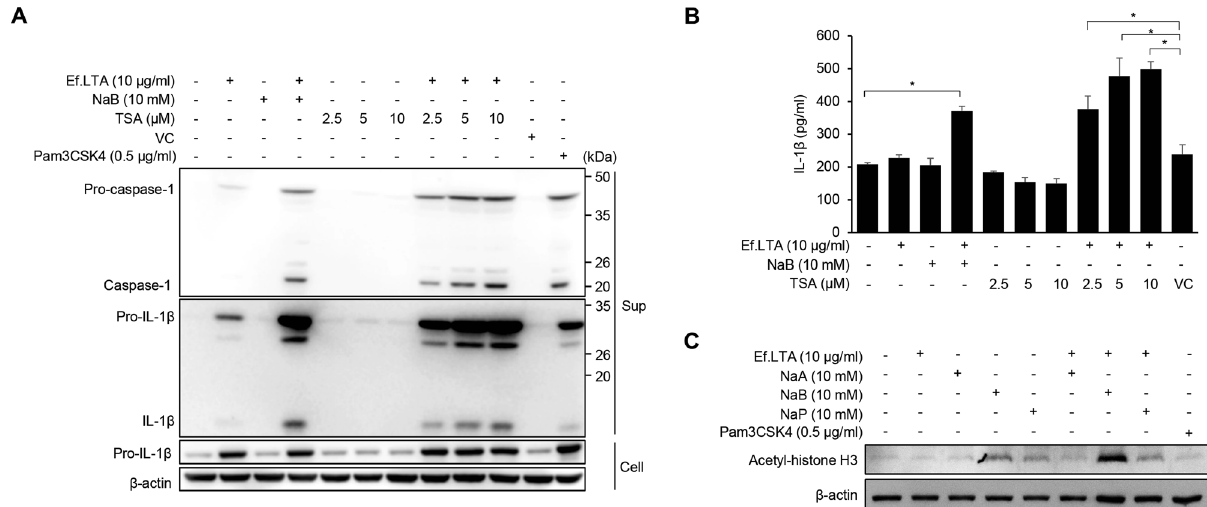
Fig. 7 HDAC inhibition is necessary for in fl ammasome activation by Ef.LTA/NaB. A PMA-differentiated THP-1 cells were stimulated with Ef.LTA (10 μ g/ml) in the presence of NaB (10 mM) or indicated concentrations of trichostatin A (TSA) for 6 h. Then, the culture supernatants were collected and the levels of pro- or active caspase-1, IL-1 β were determined by immunoblotting. B The concentrations of IL-1 β secreted into the culture supernatants was measured using ELISA. The results shown are representative of triplicate experiments. Pam3CSK4 was used as a positive control. VC denotes vehicle control (DMSO). All results are expressed as mean ± SD of triplicate samples. * p < 0.05. C The cells were stimulated with NaB, NaB, or NaP in the presence or absence of Ef.LTA. The cells were lysed and subjected to Western blotting using anti- acetyl-histone H3 antibody.